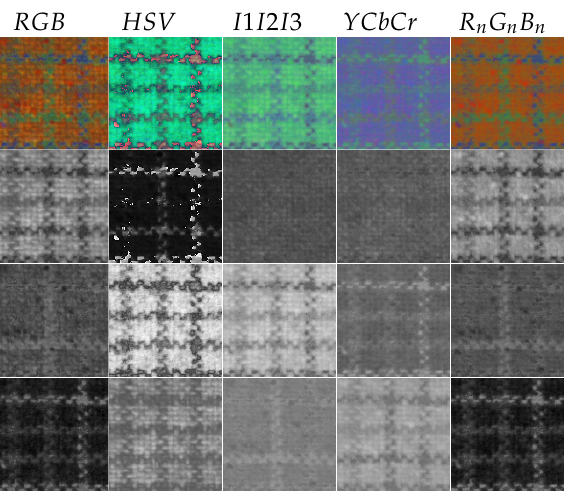
Figure 2. Image of a texture acquired in the RGB color space and converted into the HSV , I 1 I 2 I 3, YCbCr and R n G n B n device-dependent color